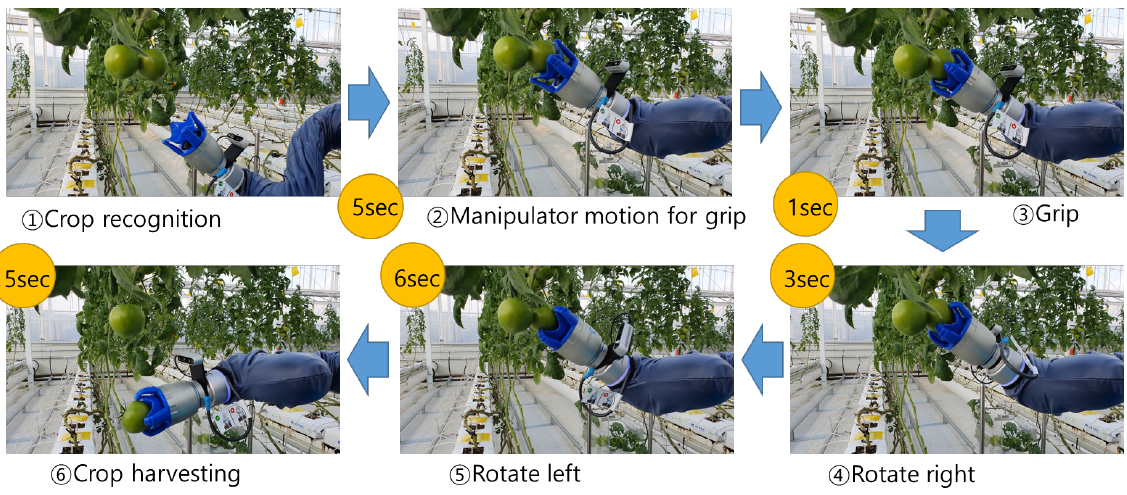
Figure 6. Crop harvesting process and speed measurement experiment using a developed harvesting